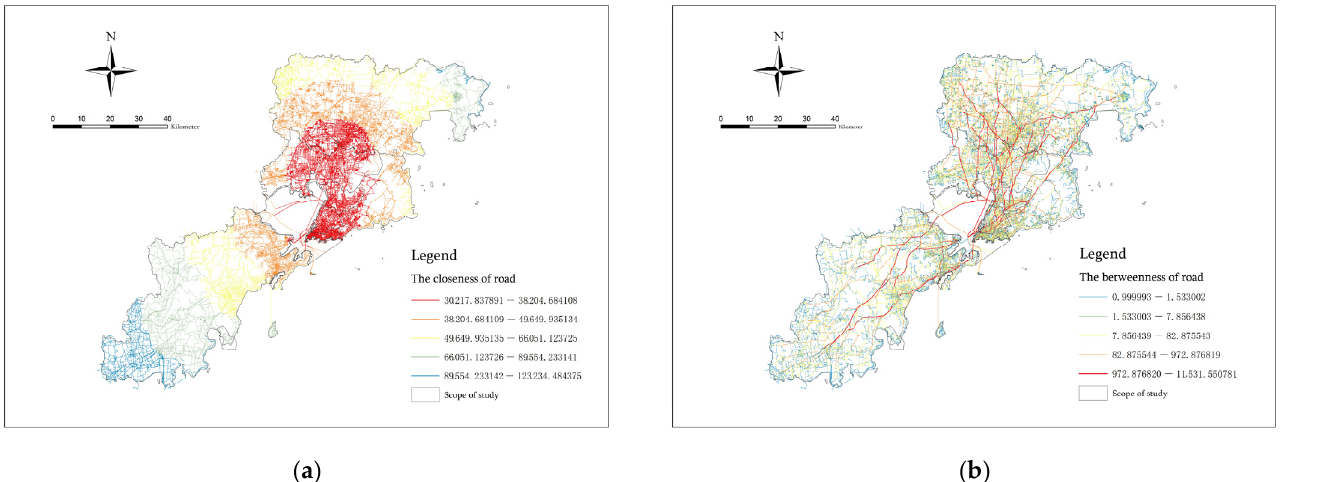
Figure 7. Visual analysis of ( a ) the closeness and ( b ) the betweenness of roads. Closeness usually reflects the accessibility of the road. It is proportional to the sum of its paths to all other roads. A location with higher accessibility indicates a central loca- tion [47]. The roads are shown in red or blue. It can clearly be seen from the closeness analysis chart that the road with the highest accessibility among the seven municipal dis- tricts of Qingdao shows obvious centrality. It is basically located in Shinan District, Shibei District, Licang District, the central area of Chengyang District, the southwest of Laoshan District and the south of Jimo District on the north side of Jiaozhou Bay. This location is basically consistent with the downtown area of Qingdao. The flow of traffic and people in this area is significant; thus, it is more likely to cause the occurrence and spread of infec- tious diseases via respiratory tract transmission and contact transmission. The Betweenness index belongs to the flow model. It reflects the potential for vehicle or pedestrian crossing movement. The betweenness of roads is proportional to the num- ber of times that people choose to cross the road and is proportional to the potential for traffic flow [48]. The roads are shown or in blue. From the analysis chart of the between- ness of roads, we can clearly see the distribution of roads with a large traffic flow and high travel potential in Qingdao. They are basically located in the main trunk of the roads in the city, the roads along the coast, the main highways and overpasses connecting the sur- rounding cities and the cross-bay bridges connecting the two banks. These roads can eas- ily carry the flow of people and become the main traffic area for people’s daily commuting and external activities. Compared with other roads, they have a higher concentration risk intensity. Moreover, these roads are highly mobile and belong to the main public space in the city, and they can very easily become an important place for air transmission and eas- ily cause the accompanying phenomenon of time and space. Therefore, the accessibility